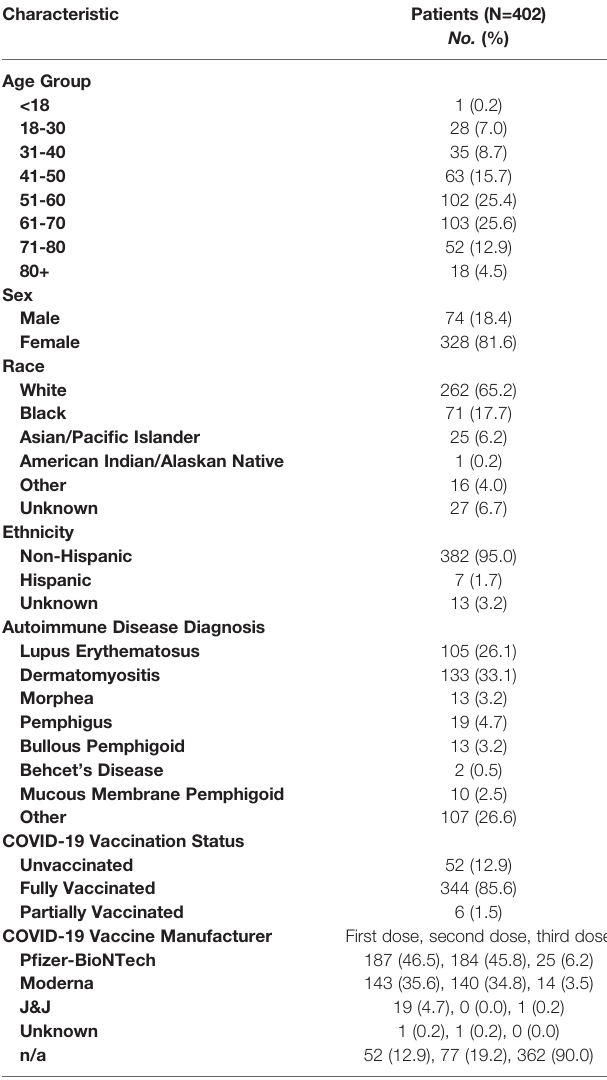
TABLE 1 | Characteristics of the study population. Characteristic Patients (N=402)